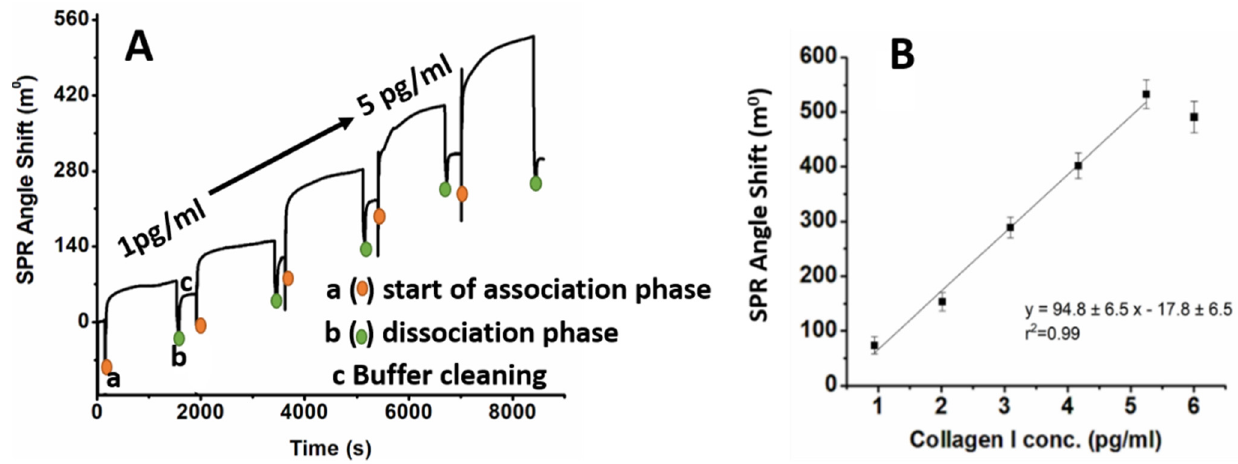
Figure 4. ( A ) SPR response, and ( B ) calibration curve of Au/TBBT/AuNPs/half-IgG/BSA towards collagen I in the concentration range from 1 pg/mL —5 pg/mL in PBS buffer.